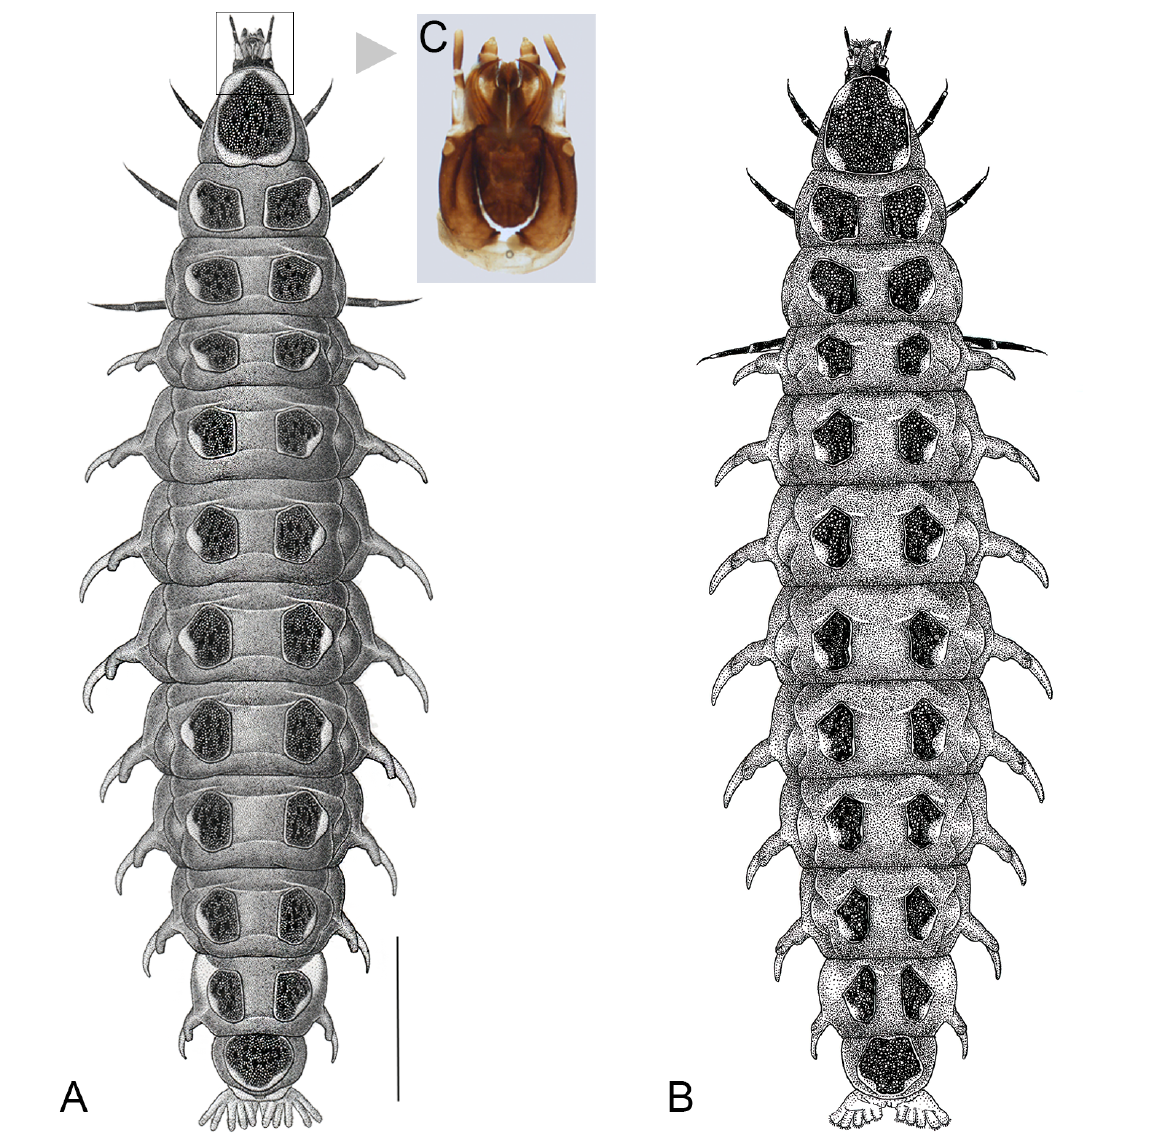
Fig. 8. Dorsal habitus larvae. A . Nipponoluciola cruciata (Motschulsky, 1854) gen. et comb. nov. B . Nipponoluciola owadai (Satô & Kimura, 1994) gen. et comb. nov. (Ohba et al. 1994). C . Head, dorsal view of A. Images by I. Kawashima (A–B) and L. Ballantyne (C). Scale bar = 5